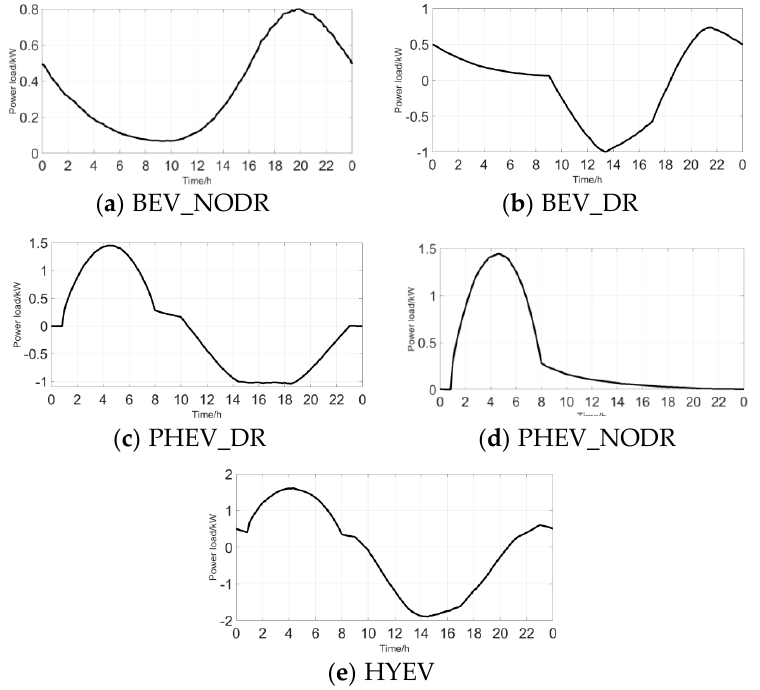
Figure 2. Typical load profiles of five classes EV.